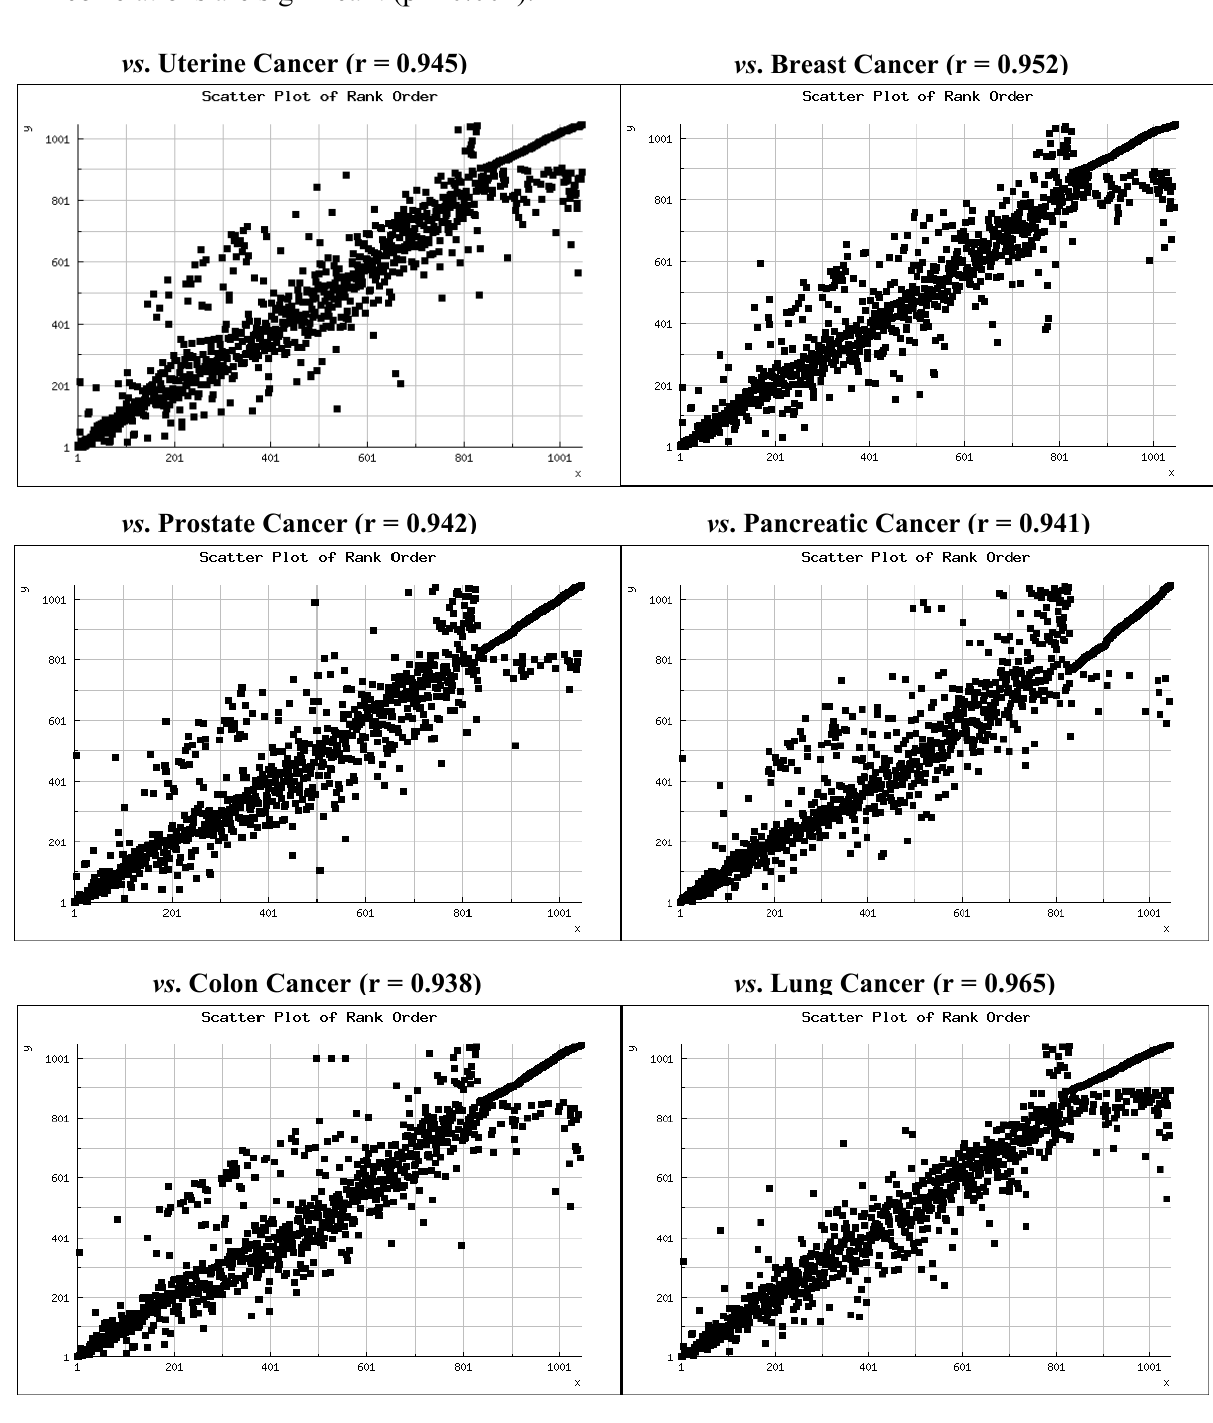
Figure 2. Scatter plots of the expression rank of 1,046 miRNAs in hepatocellular carcinoma versus six adenocarcinomas with the Spearman Rank Correlation for each. All correlations are significant (p <